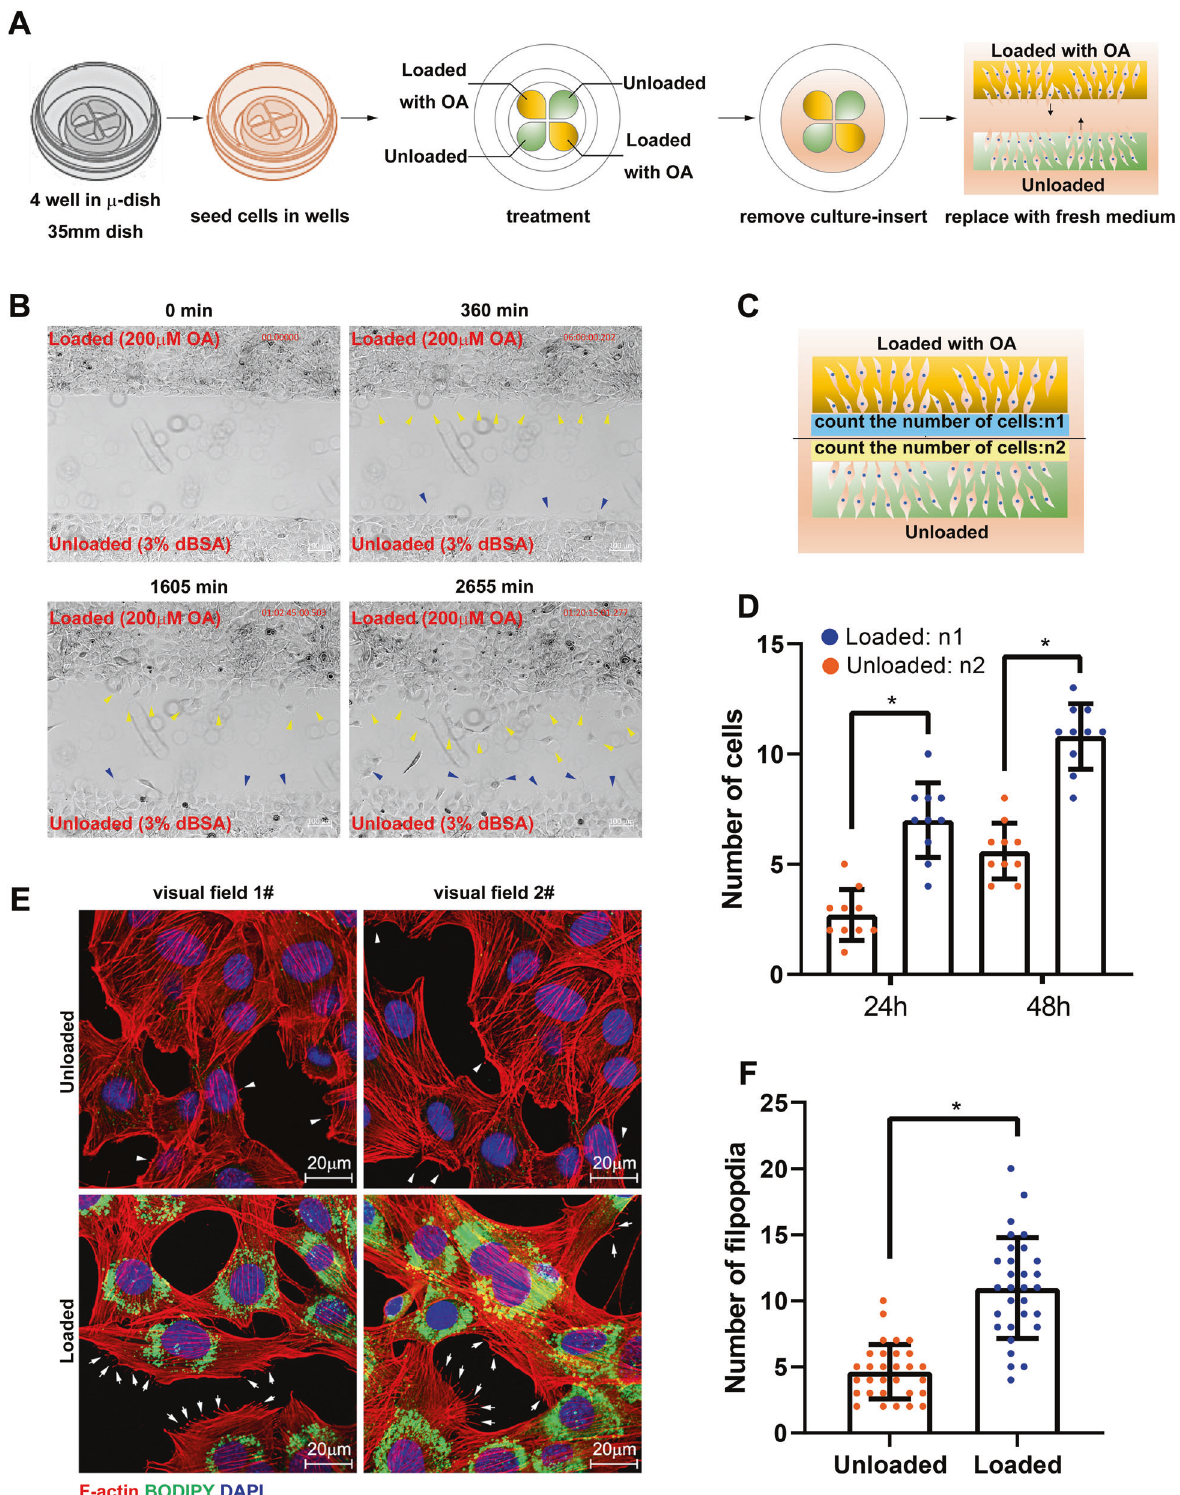
Fig. 2 LDs promote migration and fusion of myoblast. A The schematic diagram of cell migration assay. C2C12 cells were seeded in the four wells in a 35-nm dish. After treatment, the culture insert was removed, then the dish was observed in a live cell workstation. B The images of cell migration at 0, 360, 1605, and 2655 min. The yellow arrows indicate the loaded cells under migration and the blue arrows indicate unloaded cells under migration. C Schematic diagram of counting the number of migrating cells. D The number of migrating cells at 24 and 48 h. E The micro fi laments and LDs were marked in loaded and unloaded cells. The arrows indicate the pseudopodia in loaded cells and the arrow head indicate the pseudopodia in unloaded cells. F The number of fi lpopdia in E ( N = 30). * p < 0.05. Results are from three technical repeats ( N = 3) for a representative of three biological repeats ( N =